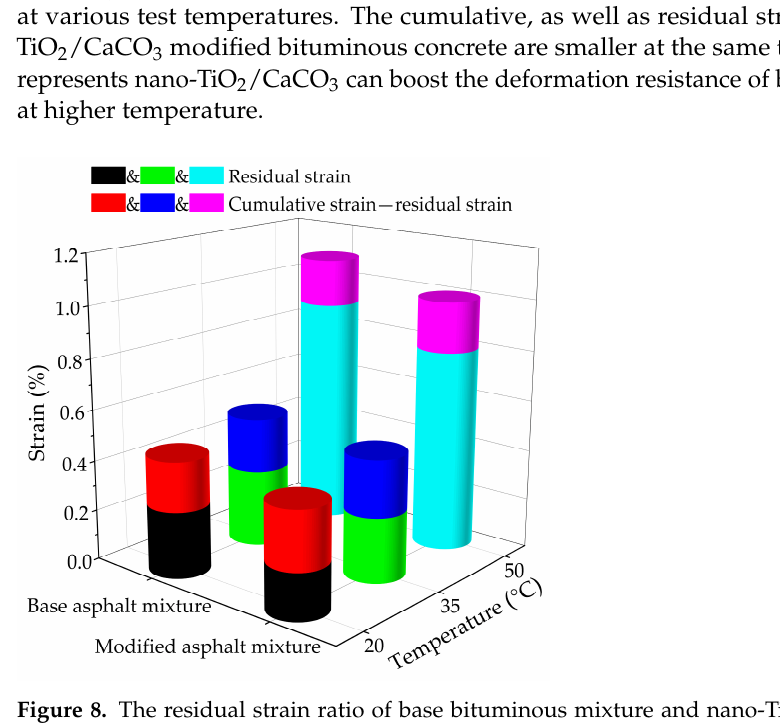
Figure 8. The residual strain ratio of base bituminous mixture and nano-TiO 2 /CaCO 3 modified bituminous mixture at different test temperatures.